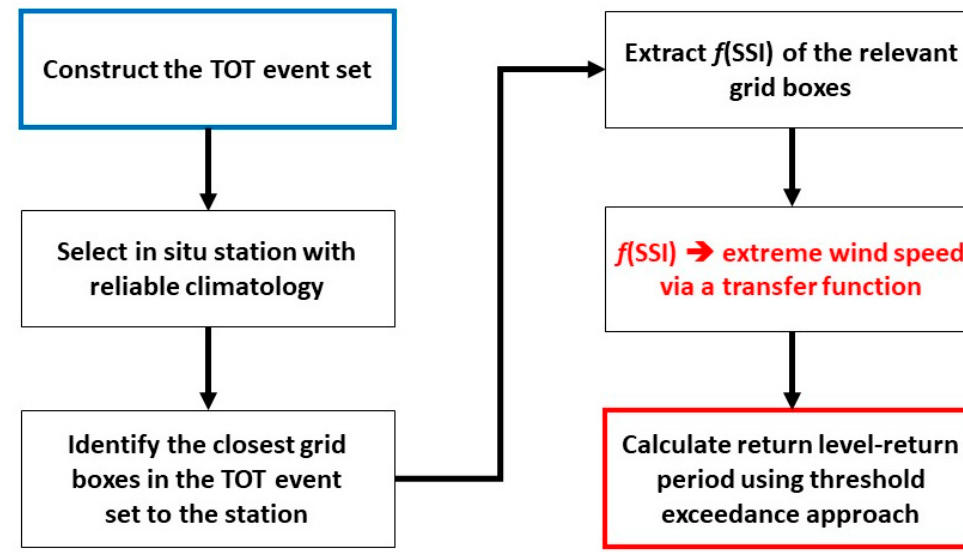
Figure A1. Workflow of the application of the TOT event set in deriving local return levels.